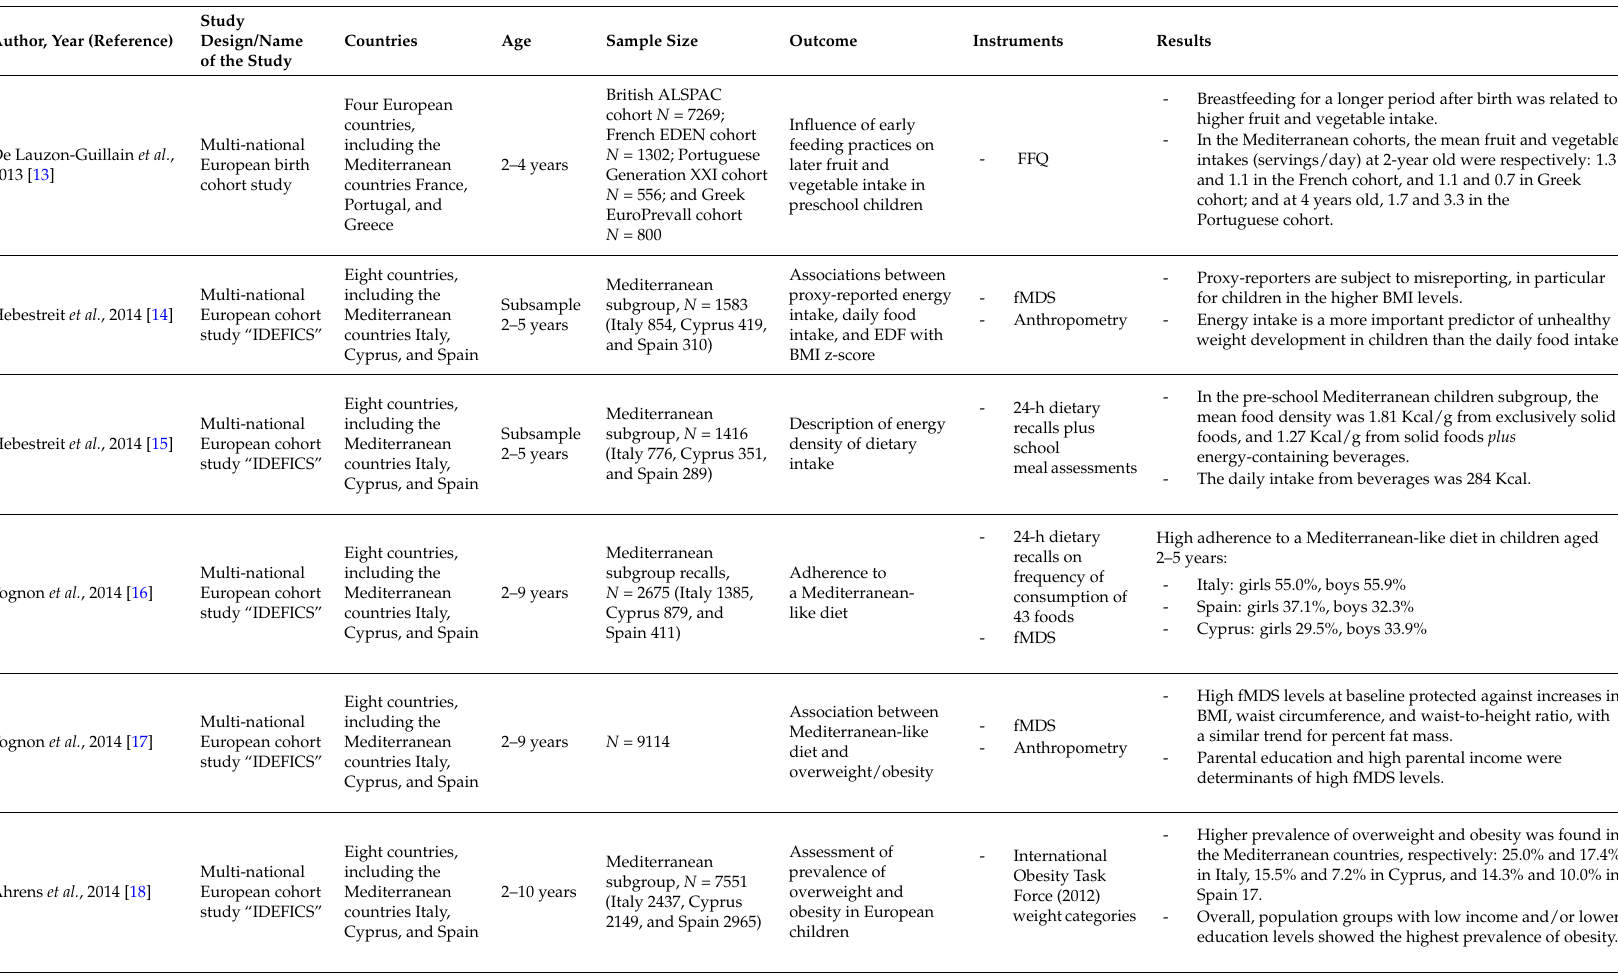
Table 1. Multi-national European cohort studies investigating dietary habits, in comparison to the Mediterranean diet-like pattern, and weight status of preschool children, including those living in Mediterranean countries of the European